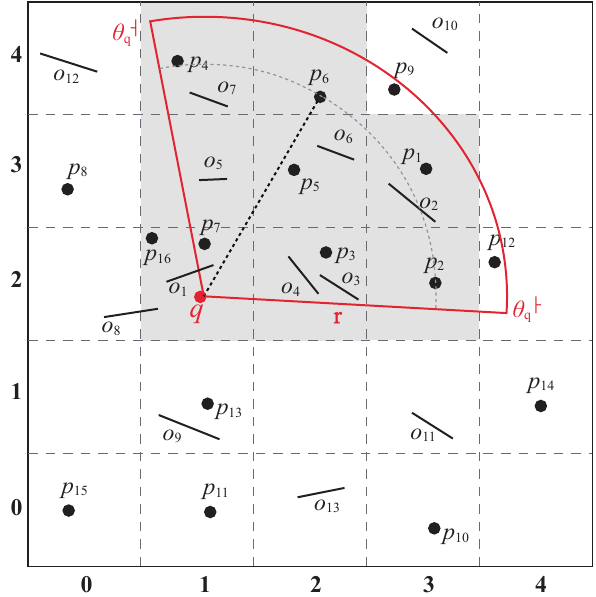
Figure 14. An example of the baseline